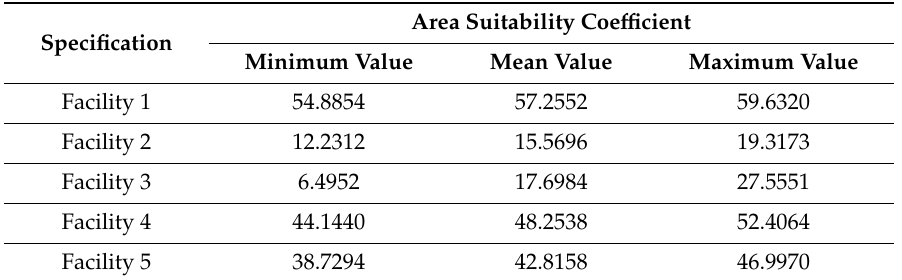
Table 6. Values of area suitability coefficients LR for the analyzed facilities.